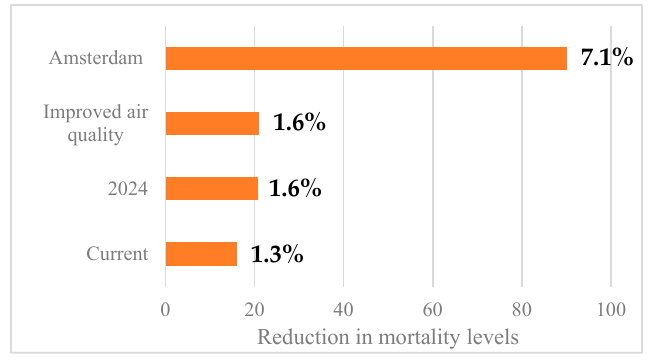
Figure 7. Absolute and percentage reduction in the number of deaths in the age range of 20–64, in Milan, in 2015.